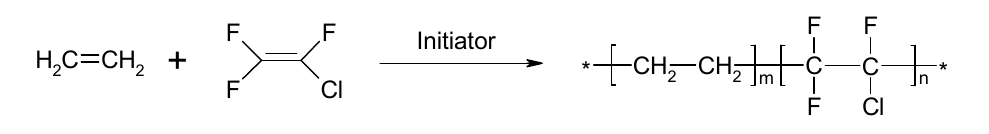
Figure 7. The preparation of ECTFE.